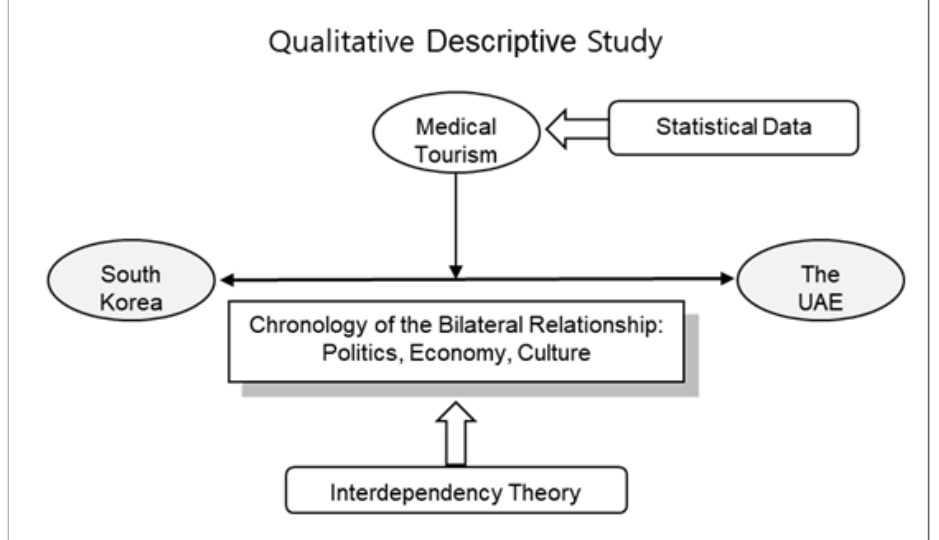
Figure 1. Flowchart of the research methodology.